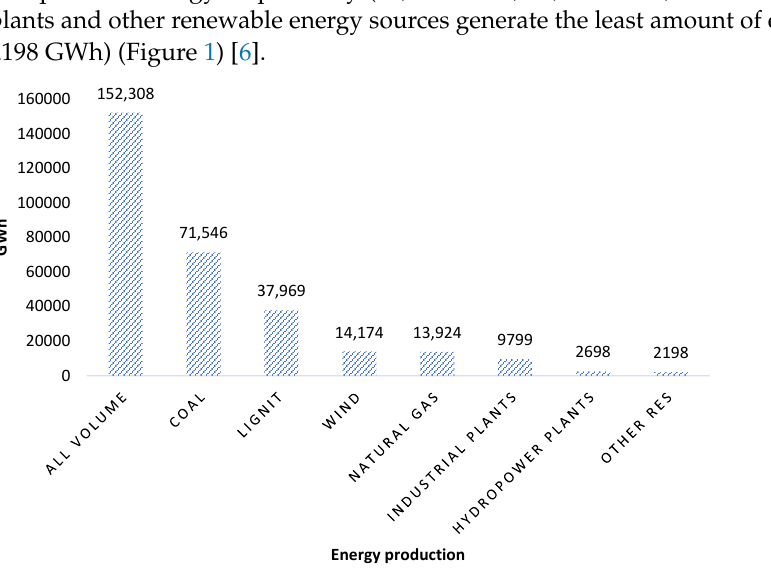
Figure 1. Structure of energy production in 2020, GWh [6].